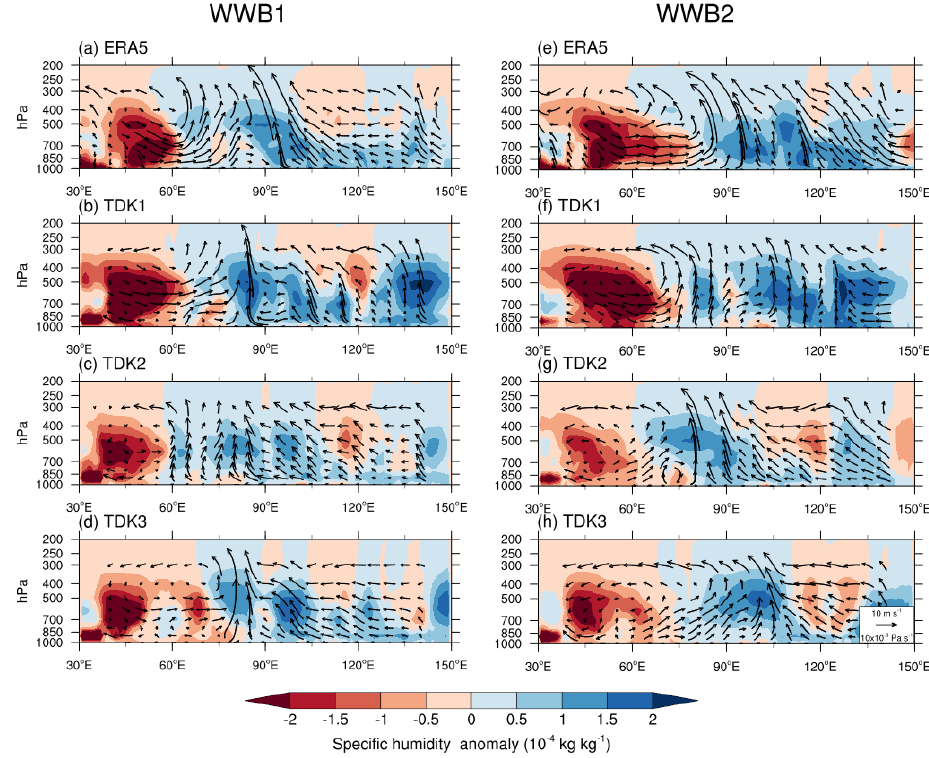
Figure 4. Vertical structure of the two MJO events. Composited zonal (10 m s − 1 ) and vertical ( − 10 × 10 − 3 Pa s − 1 ) winds for ( a , e ) ERA5, ( b , f ) TDK1, ( c , g ) TDK2, and ( d , h ) TDK3. Two-day averaged results are shown in the left panels (right) panels when the WWB1 (WWB2) convective center is located near 90 ◦ E. The selected time range of the WWB1 is 22 to 23 November 2011. For the WWB2, the time range is 27 to 28 (28 to 29) November 2011 in the ERA5 and the TDK1 (the TDK1 and TDK2 experiments). The shading indicates the specific humidity anomalies (10 − 4 kg kg − 1 ). The mean value of the specific humidity for each level is removed from the specific humidity to get the